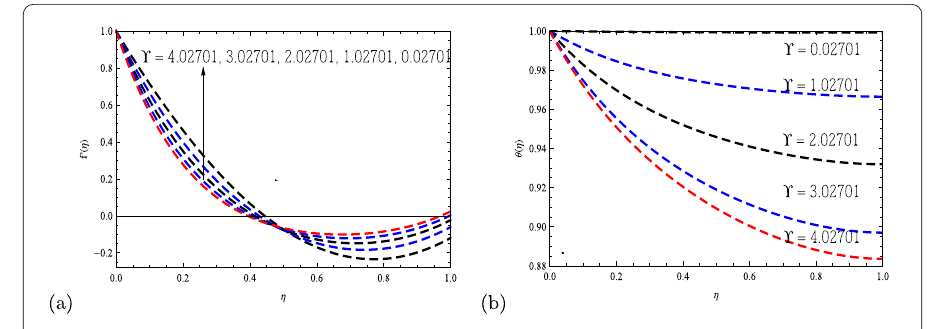
Figure 8 The effect of ϒ on velocity profile and temperature profile with K = 0.1, M = 1, Ma = 5, Pr = 0.2, Gr = 5, S = 0.2.